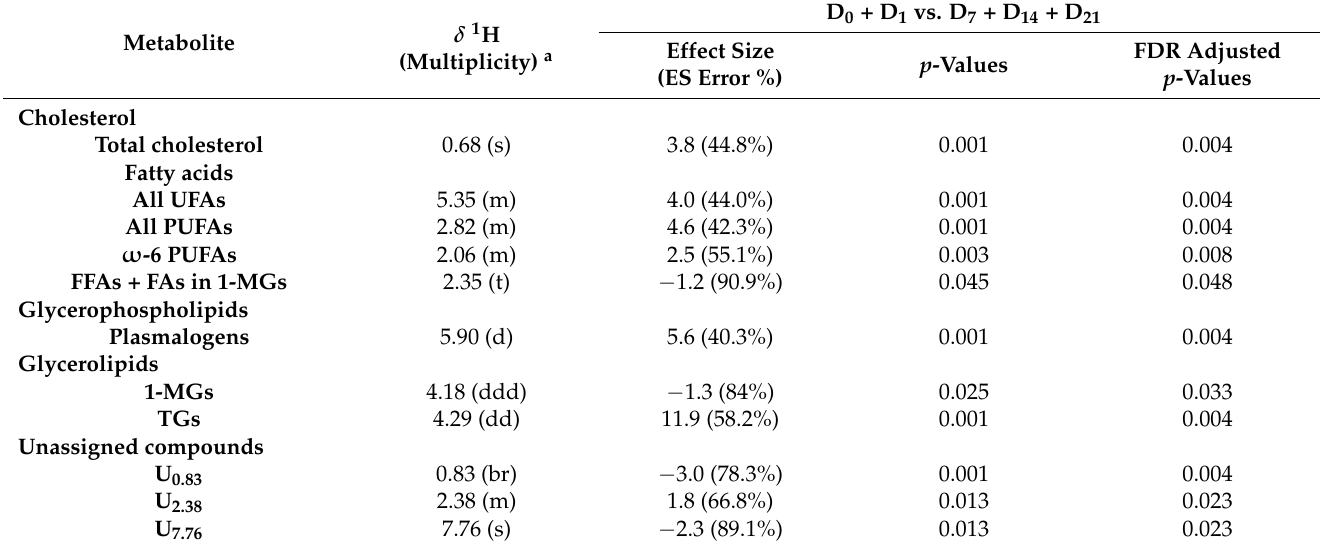
Table 1. Main lipidic variation between the initial days (0 and 1) and later days (7, 14, and 21) of osteogenic differentiation of hAMSCs. All differences presented were confirmed by visual inspection of the spectra and are statistically significant (Wilcoxon Rank-sum test p -values < 0.05) [52]. Effect size (ES) values and corresponding errors were calculated as described in reference [53] (level increases and decreases in the later days are represented by positive and negative ES values,